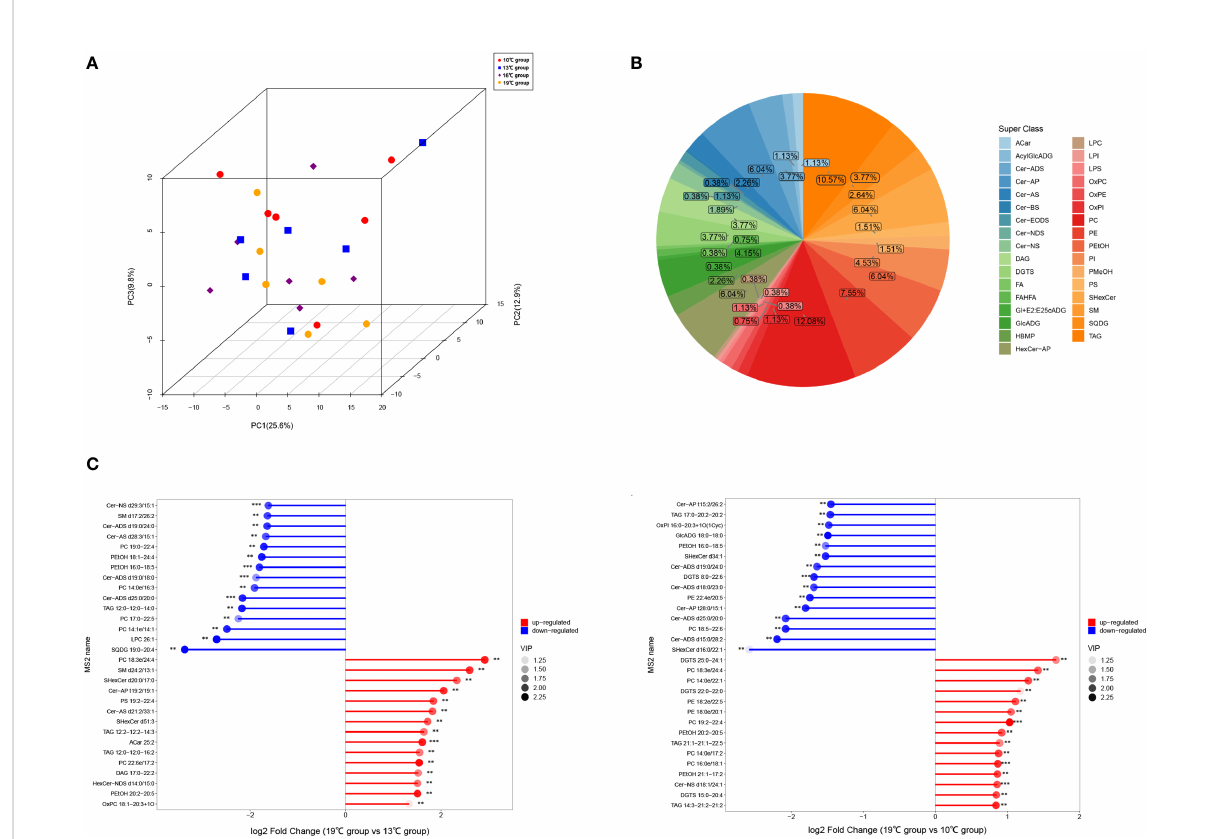
FIGURE 3 Results of untargeted lipidomics based on UHPLC-QTOF-MS analysis. (A) PCA plots of the samples. (B) Classi fi cation of differential lipids among four temperature groups. (C) Differential lipids with high fold change in 19°C group vs. 13°C group, and 19°C group vs. 10°C